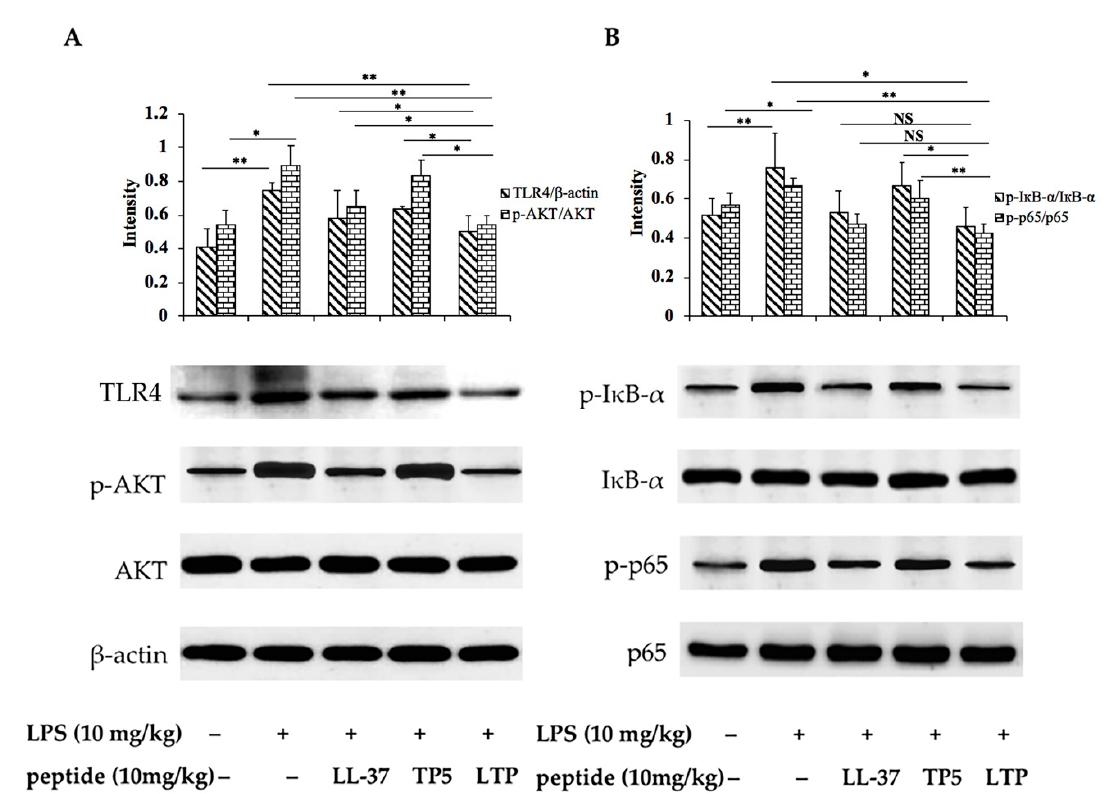
Figure 8. Inhibitory e ff ect of LTP on the NF- κ B signalling pathways in mice. Phosphorylated and total protein levels of TLR4, AKT, and β -actin ( A ); I κ B- α and p65 ( B ) in jejunal tissues were measured by Western blot analyses. Data are presented as the mean value ± standard error from three biological replicates. NS: p > 0.05, *: p ≤ 0.05, **: p ≤ 0.01.